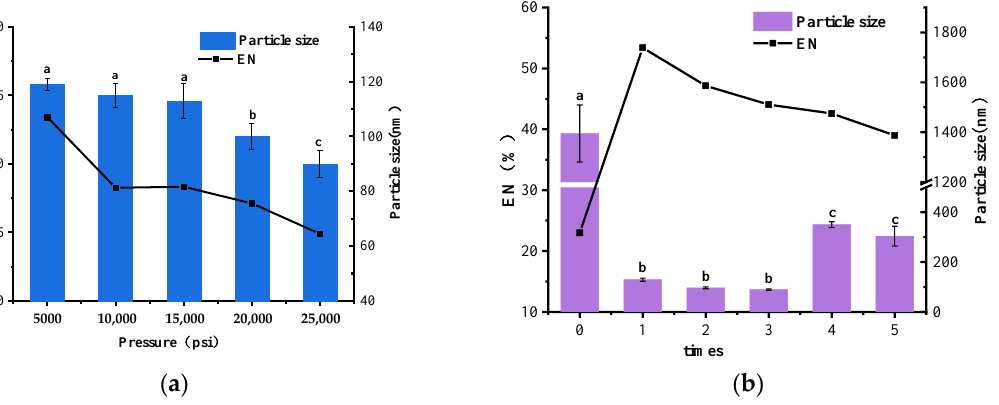
Figure 3. Effect of different homogenization pressures on the particle size and encapsulation rate of SLN-CA during preparation in a single-factor experiment ( a ); effect of different homogenization times on the particle size and encapsulation rate of SLN-CA during preparation in a single-factor experiment ( b ); error bars indicate the standard deviation of the mean (three replicates); different letters a – c in the figure indicate significant differences in particle size results between treatments based on Duncan’s multiple range test ( p < 0.05).